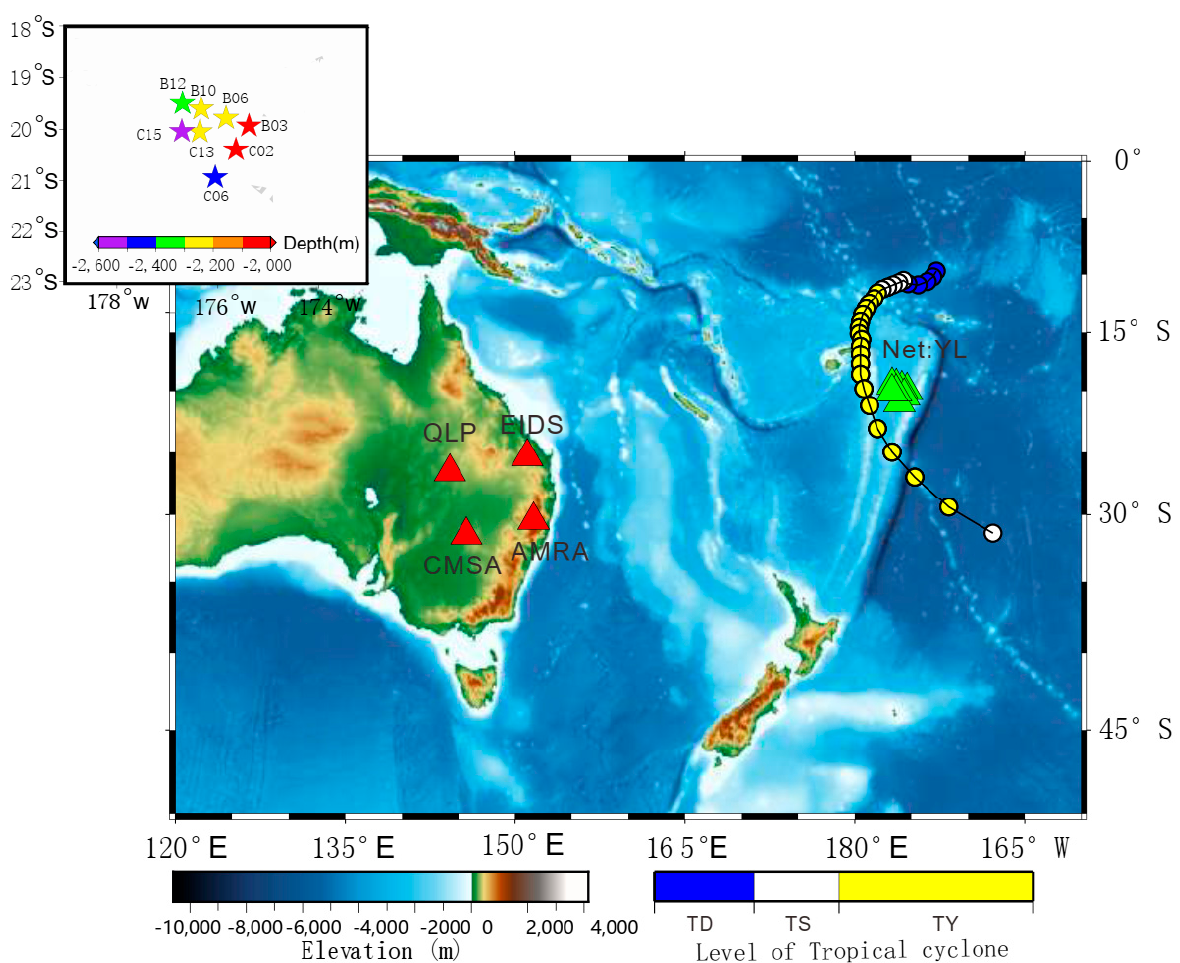
Figure 1. The location of YL array, green triangles, and four AU stations, red triangles. The circles represent the best tracks of the TOMOS cyclone from JTWC. Inset is the configuration of 8 YL array stations used in the study. TD stands for tropical depression with maximum wind speed 0–34 km/h. TS stands for tropical storm with maximum wind speed 34–63 km/h. TY stands for typhoon with maximum wind speed 63–129 km/h.